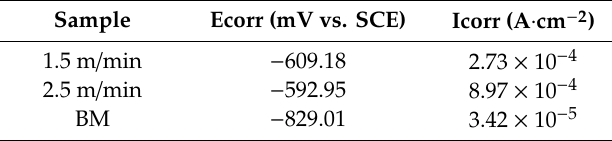
Figure 8. ( a ) Open circuit potentials and ( b ) potentiodynamic polarization curves of BM sample and welded joints. Table 3. The potentiodynamic polarization results of the BM sample and welded joints.